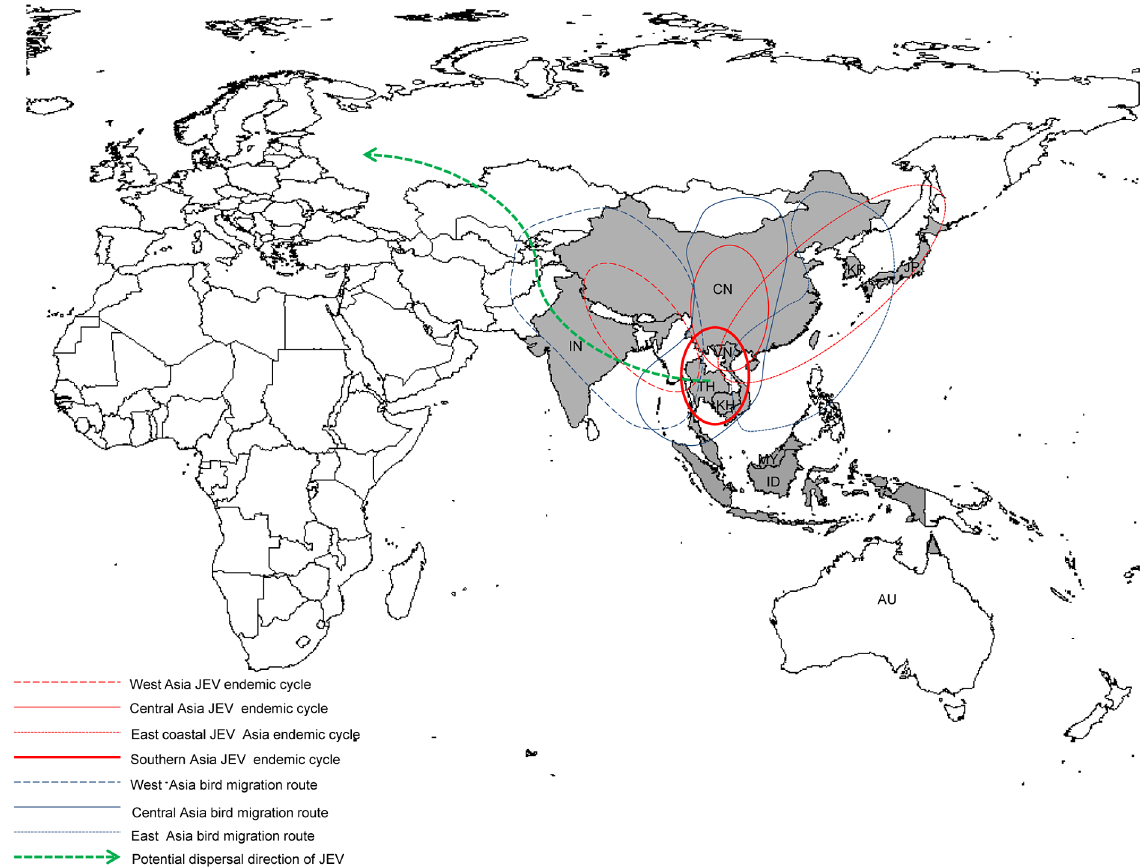
Figure 3. Dispersal characteristics of genotype 1 JEV based on phylogenetic analysis. Gray shadow presents the location of JEV strains used in this study; emboldened circle represents southern Asia endemic cycle established in the JEV transmission source area; red circles presented as dashed lines, intact lines circle and square dot lines represent west Asia, central Asia and east coastal Asia JEV endemic cycles, respectively; blue boxes presented as dashed lines, intact lines and square dots represent bird migration routes in Asia and they coincide with JEV endemic cycles; green dotted lines illustrate the potential dispersal directions of JEV in the future. CN, China; JP, Japan; KR, South Korea; IN, India; VN, Vietnam; TH, Thailand; KH, Cambodia; MY, Malaysia; ID, Indonesia; AU, Australia.